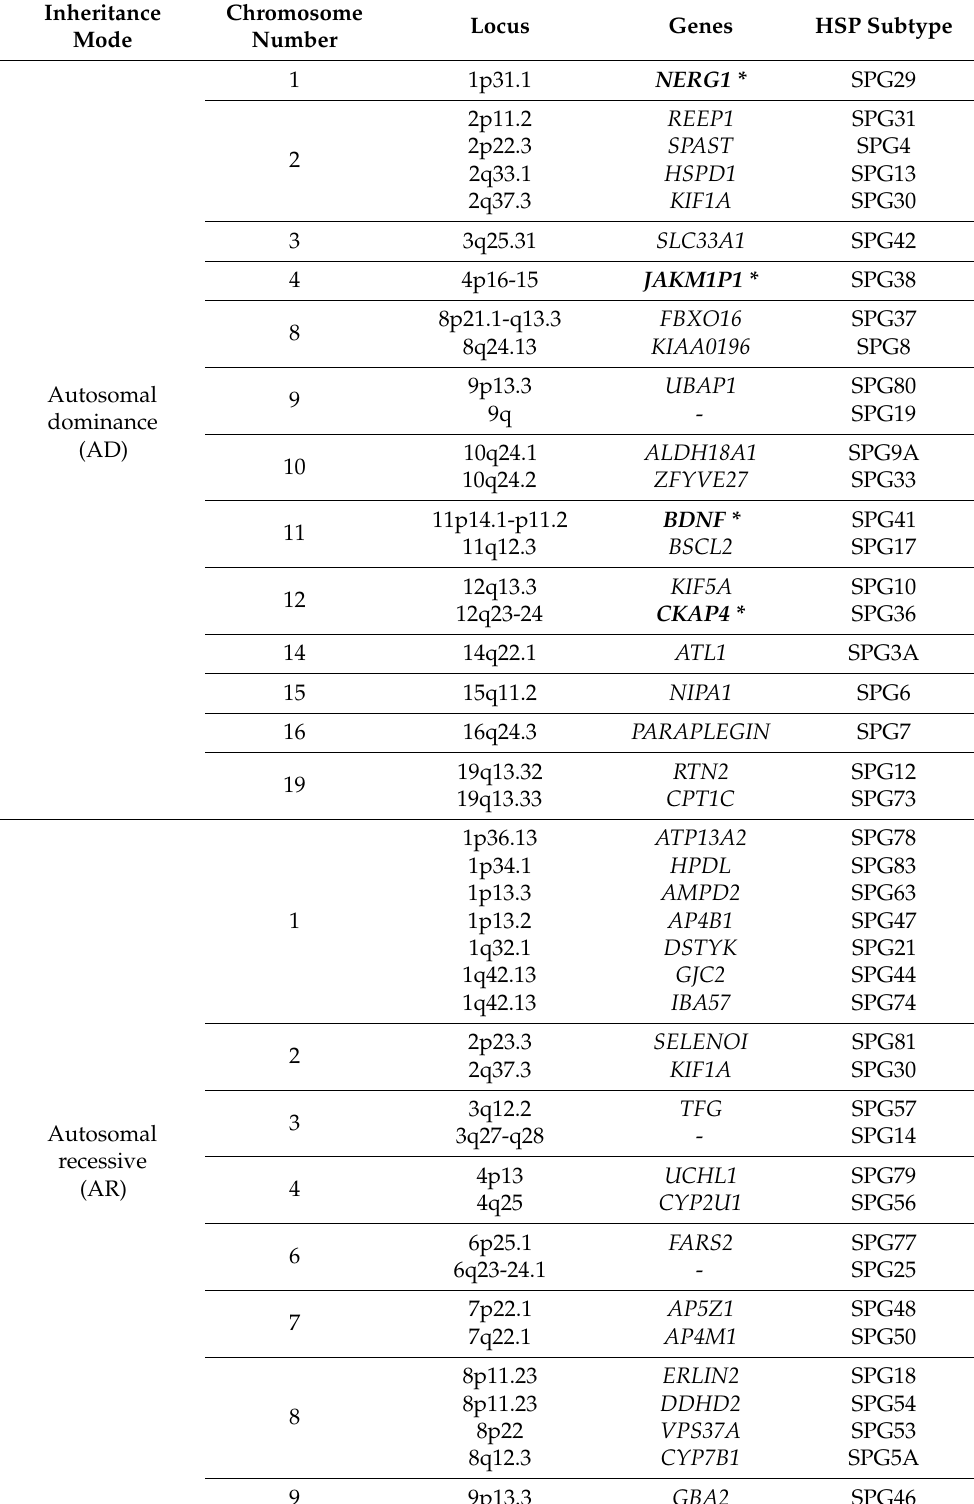
Table 3. Chromosomes, loci, and genes involved in HSPs and their